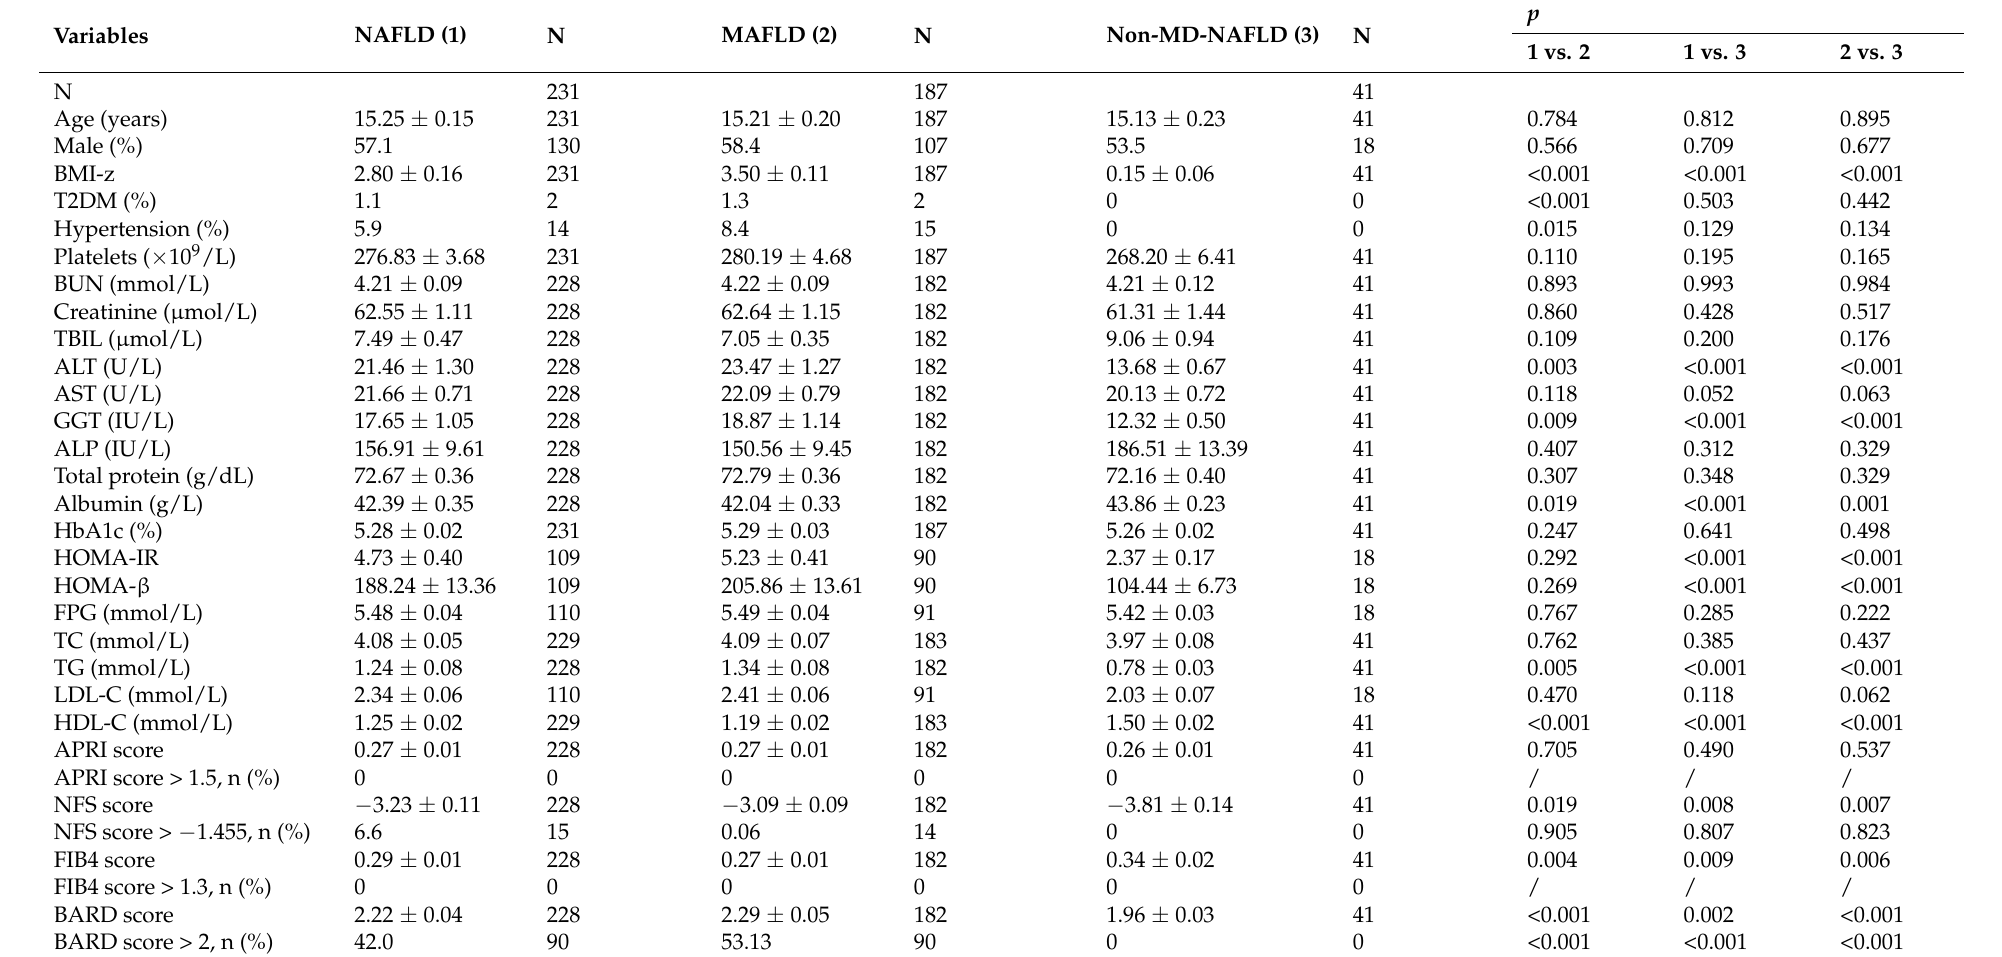
Table 2. Comparison of clinical parameters according to presence of MAFLD, NAFLD and non-MD-NAFLD group by VCTE in NHANES